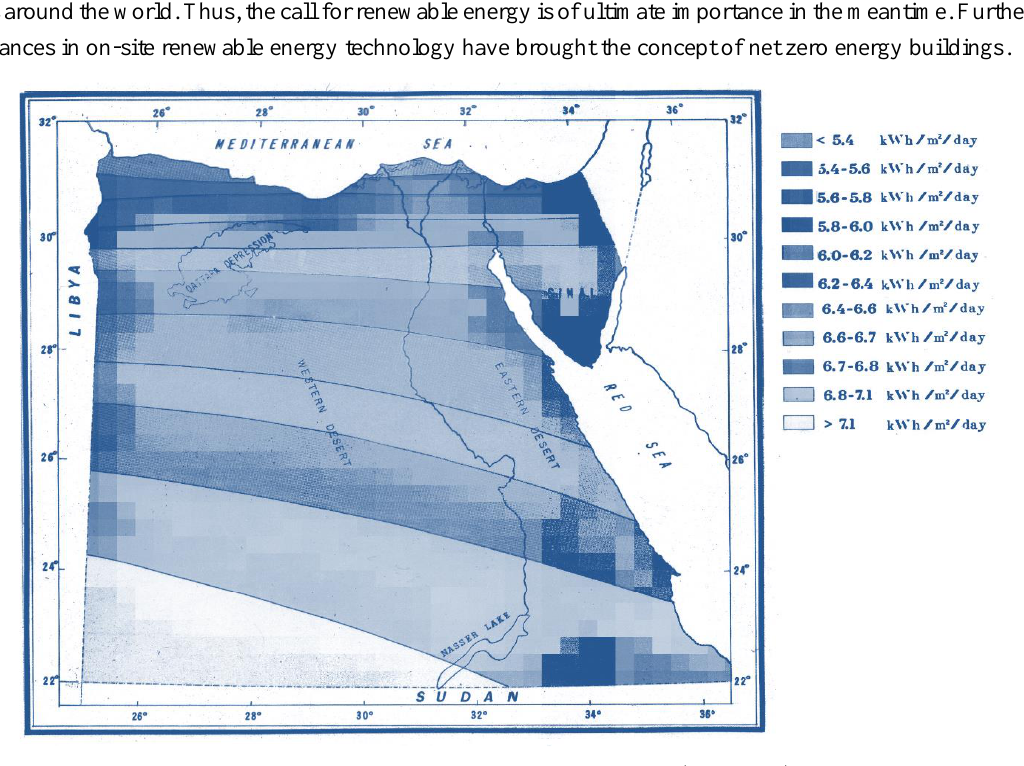
Figure 2. Egypt annual average of direct solar radiation (EEAA